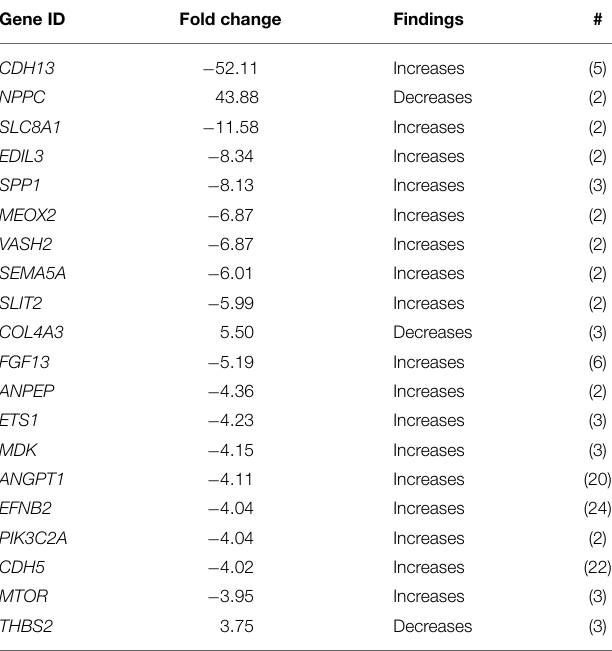
TABLE 5B | Genes predicting an inhibition of Formation of neurites between GD90 and GD165.